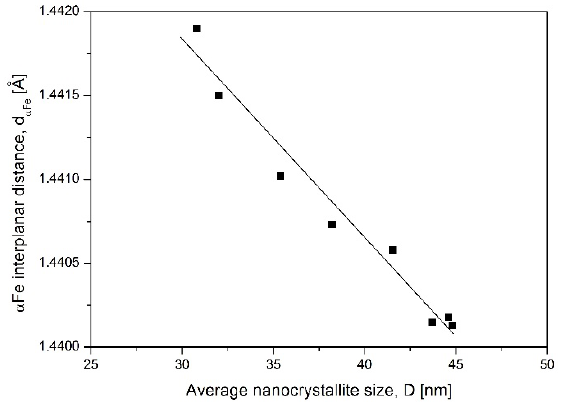
Figure 5. The dependence of αFe interplanar distance on its average crystallite size.